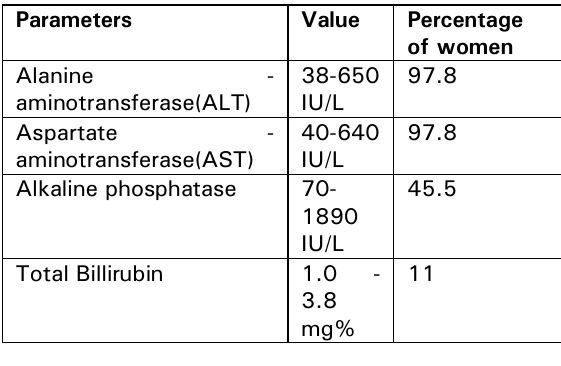
Table 2 : Liver Function Tests